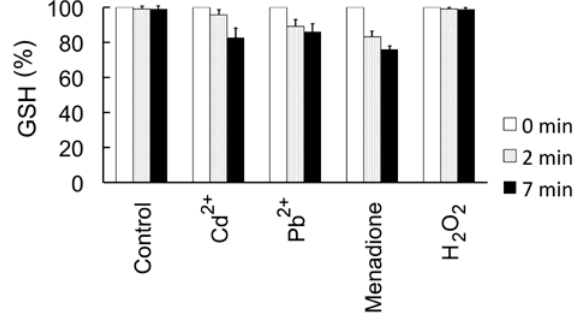
O and menadione on intracellular levels of GSH. 2 2 , 1 ppm Pb(CH COO) , 1 ppm 2 3 2 O . Control corresponds to cells treated with H O. Six replicates 2 2 2